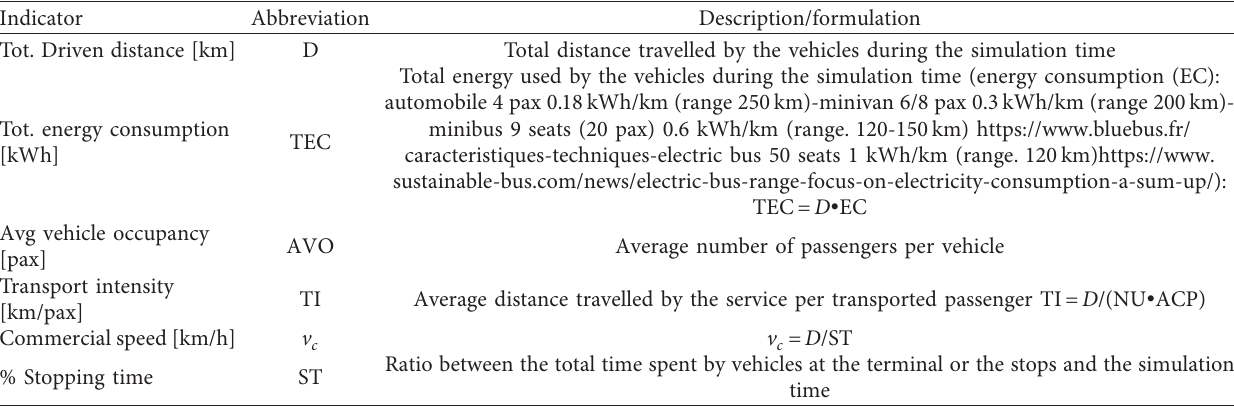
Table 2: Description of the operator-related output indicators.